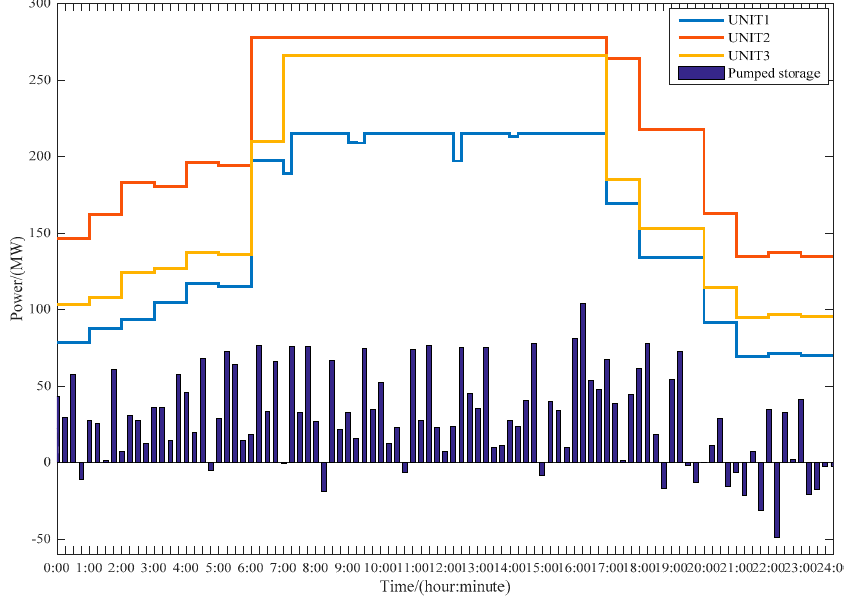
Figure 5. Active power outputs of thermal power generators and hydro-pumped storage units under the hour-level rolling corrective